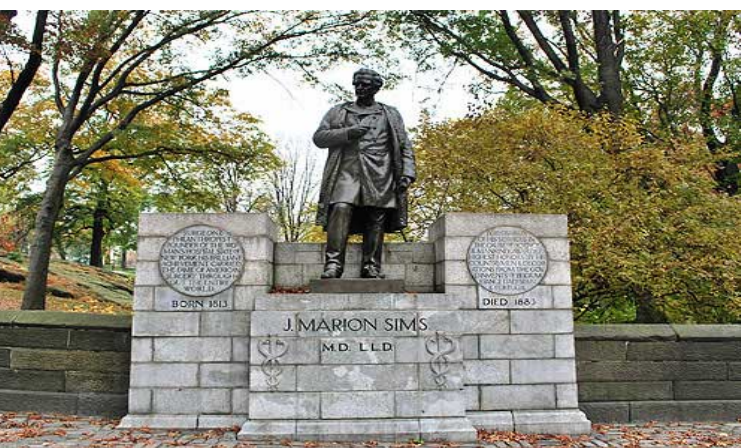
Figure 4. Image Dr. J Marion Sims Statue, New York’s Central Park. Photograph (taken by author) 2013.